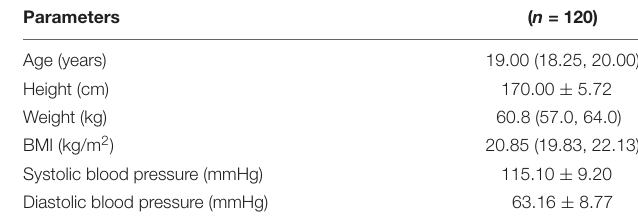
TABLE 1 | Characteristics of study